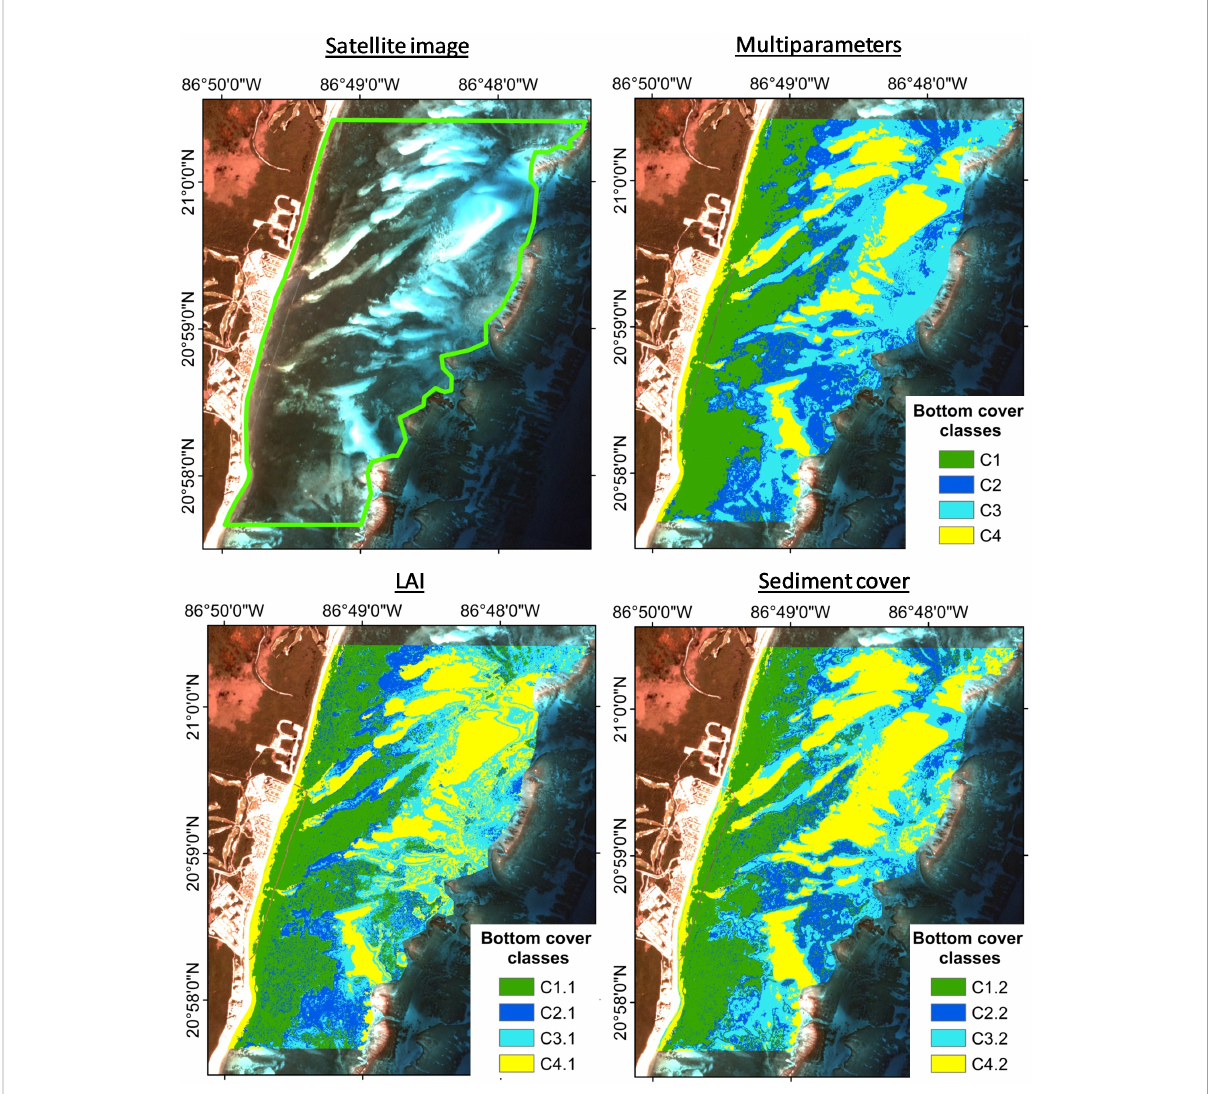
FIGURE 9 Comparison of supervised classi fi cation results obtained with multiparameter seeds, LAI seeds, and sediment cover seed, using the KNN